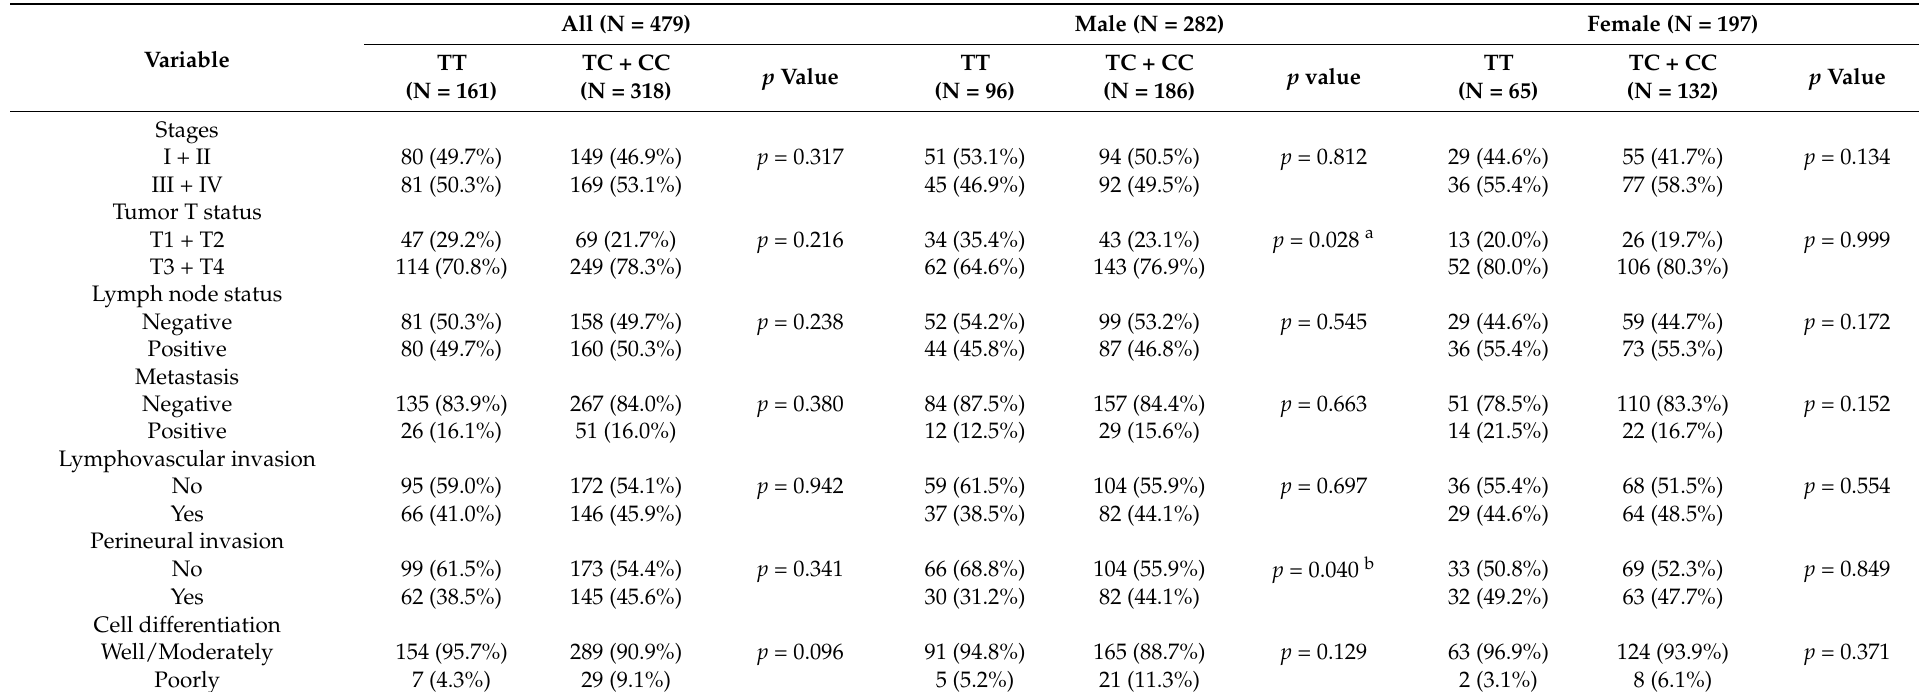
Table 4. Distribution frequency of the clinical status and MMP-11 rs131451 genotype frequencies in 479 CRC patients with different